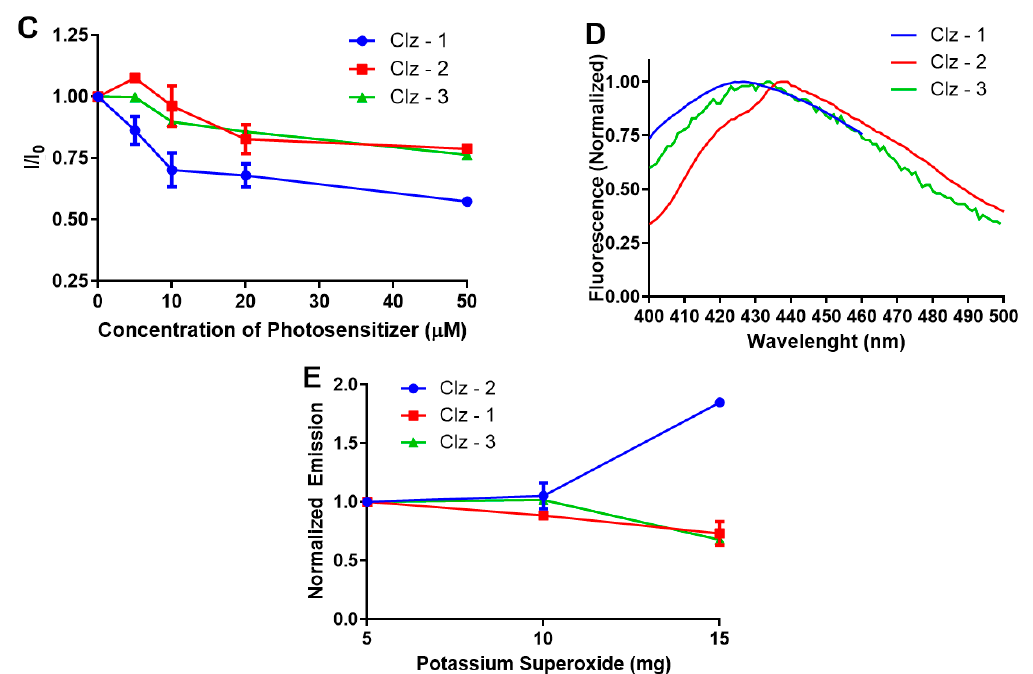
Figure 2. ( A ) Chemiluminescence output (in relative light units (RLU)) of Clz–1, Clz–2, and Clz–3 in methanol upon addition of 5 mg of potassium superoxide. ( B ) Normalized chemiluminescence emission, as a function of time (ms), for the three Coelenterazine derivatives in methanol upon addition of 5 mg of potassium superoxide. ( C ) Effect exerted on the fluorescence (I/I 0 ) of ABDA, as a function of the concentration of the three Coelenterazine derivatives. ( D ) Fluorescence spectra of Clz– 1, Clz–2, and Clz–3 in methanol. ( E ) Normalized chemiluminescence emission of Clz–1, Clz–2, and Clz–3 in methanol, as a function of the added amount of potassium